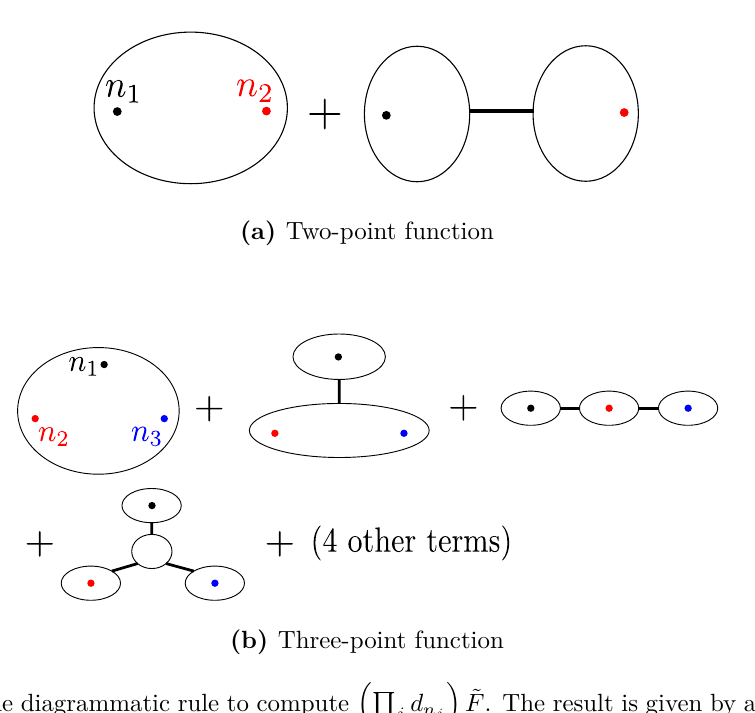
Figure 10. The diagrammatic rule to compute ucts of disconnected orrelators (denoted by spheres with punctures) joined together by wormholes (denoted by thick black lines). In (b), there are four other diagrams that can be obtained from the second and the third diagrams by the permutation of